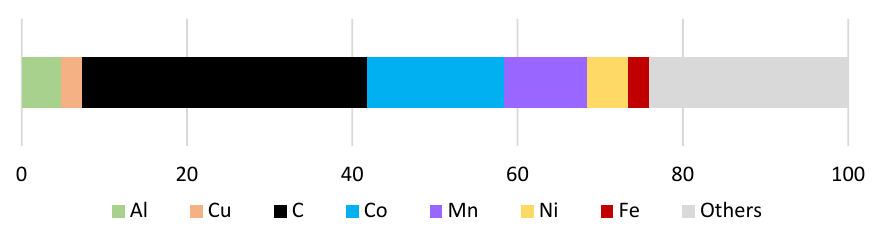
Figure 1. Chemical composition of the spent black mass by XRF and C assay. The group “Others” corresponds to the elements below 1 wt.% content and light elements excluding C such as Li, O, and F.